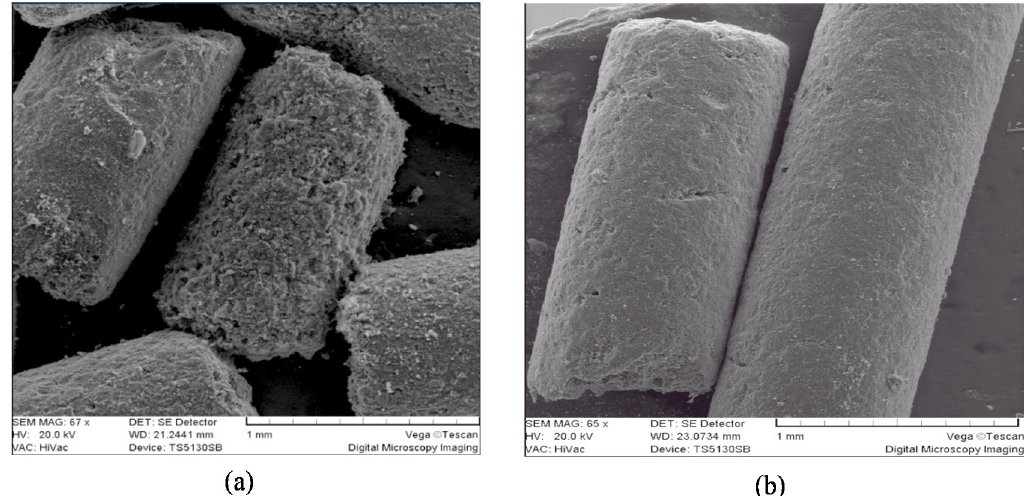
Figure 5. Digital microscopic images of samples of “virgin” GAC-1 ( a ) and “exhausted” GAC-5 ( b ) before and after use in a rum production process.